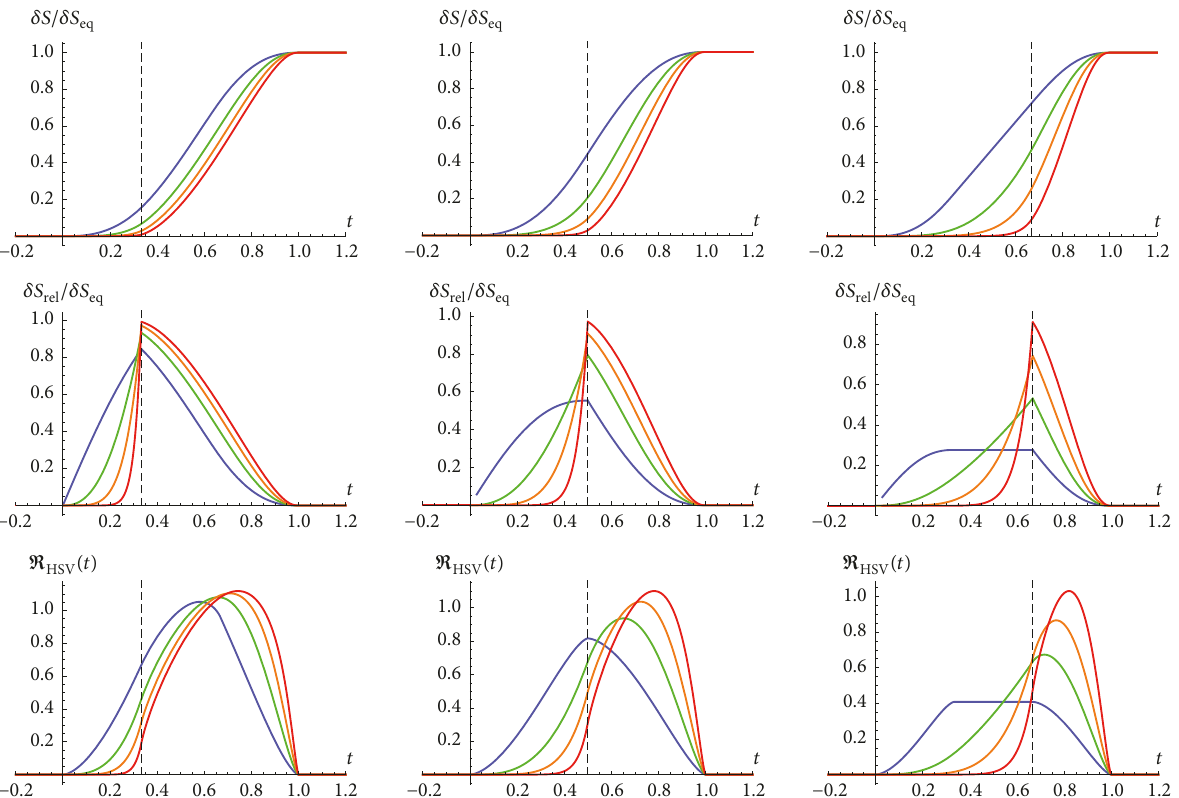
Figure 7: Entanglement entropy, relative entropy, and entanglement velocity for different powers after a power-law quench. Colors blue, green, orange, and red represent 𝑝 = {1,2.5,5,11.5} , respectively. Plots from left to right have 𝑡 𝑞 /𝑡 ∗ = {0.5,1, 2} . In all plots, the dashed vertical line denotes the end of the driven phase 𝑡 = 𝑡 𝑞 . We have set 𝑑 = 3 , 𝜃 = 0.1 , and 𝑧 = 1.5